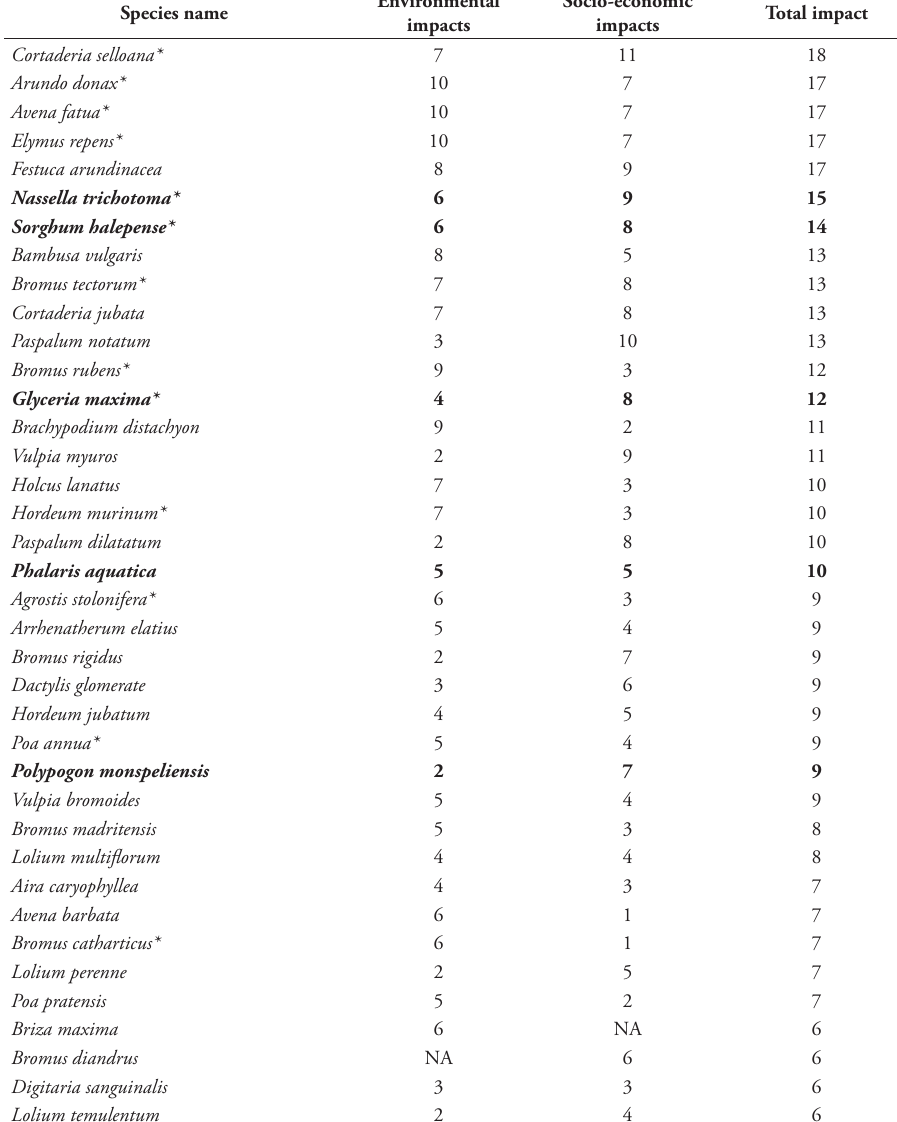
Table 1. Grasses alien to South Africa and one other region (Chile, Europe, Australia and the USA) ranked according to impacts. The numbers under environmental and socio-economic impacts are the respective sums of the maximum impact scores per impact mechanism of a species. Species that score a maximum of 5 in any one impact mechanism are highlighted in bold. NA indicates no impact found for that species, hence not applicable. Total impact represents the overall sum of the environmental and socio- economic impacts. Species marked with an asterisk* have impacts recorded in South Africa. Literature used and detailed maximum scores per mechanism are available in the Supporting Information (Appendix S1 and Table